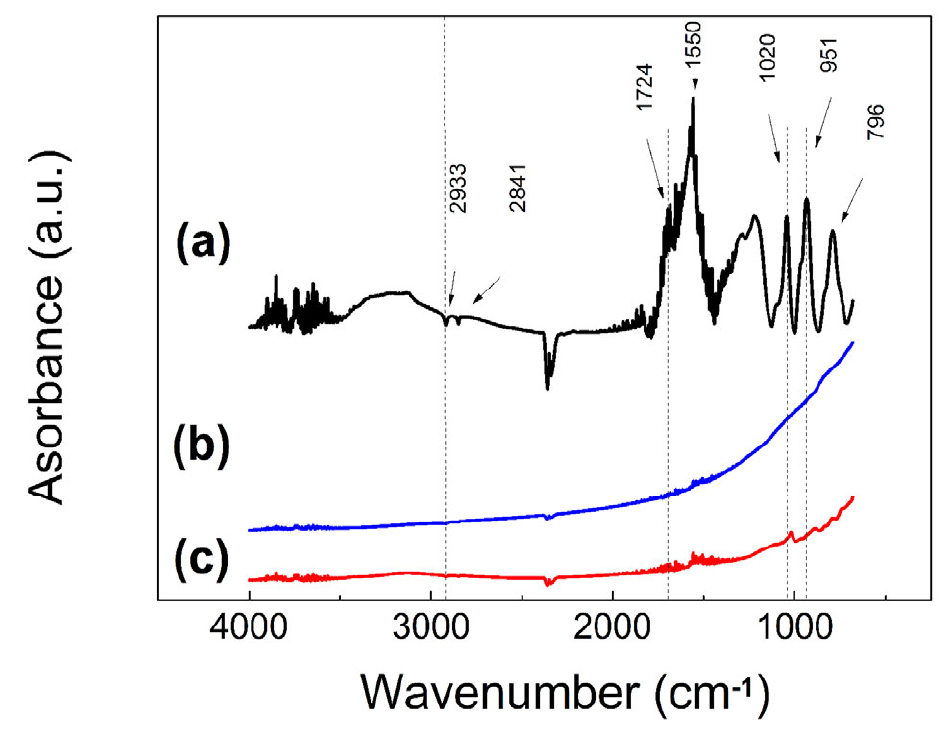
Figure 3. FTIR spectra of the PPEMA polymer ( a ), neat CI particles ( b ) and CI-PPEMA particles ( c ).